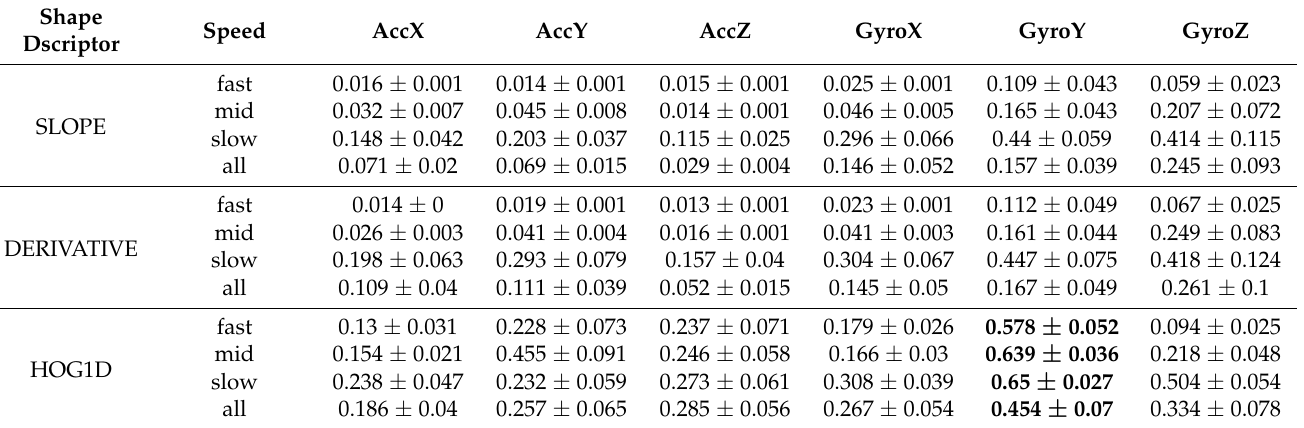
Table 4. Stride segmentation results for fluctuation-capturing-descriptors in F-measure values. Best results for each speed group are highlighted in bold